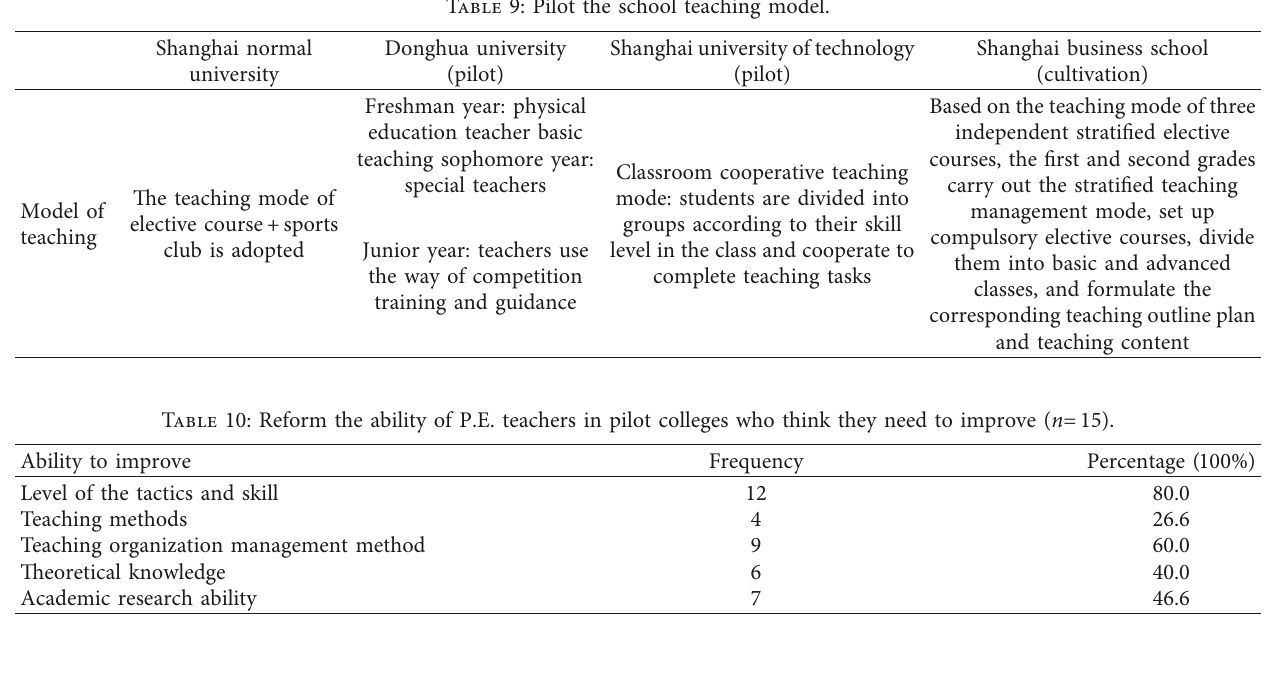
Table 11: Improved physical test scores of college students after teaching reform ( n � 408).